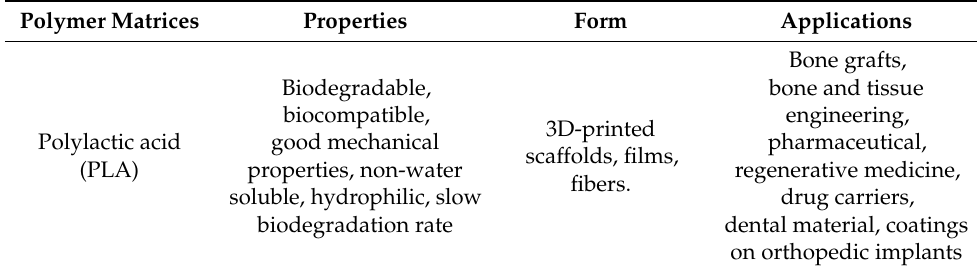
Table 2. CaP-containing synthetic polymer composites in bone tissue